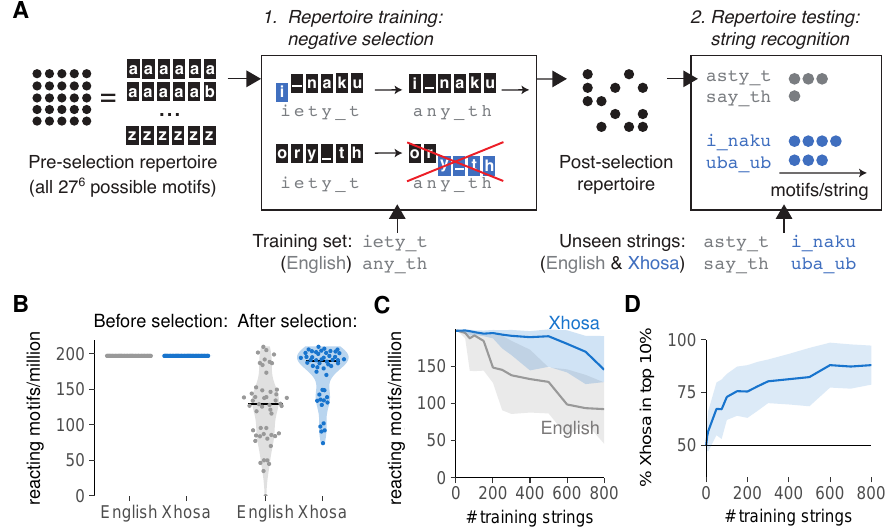
Figure 3. An artificial immune system tasked with language recognition discriminates self and foreign after negative selection on a subset of self. ( A ) Simulating negative selection in silico: (1) Motifs in the unbiased pre-selection repertoire (with all possible 27 6 ≈ 400 million motifs of six characters (a–z and _)) are deleted if their affinity for any of the training strings exceeds the functional response threshold t . (2) Unseen English and Xhosa strings are exposed to the post-selection repertoire to find the number of remaining motifs reacting to them with affinity ≥ t ; ( B ) reacting motifs per million for unseen English and Xhosa strings, before and after negative selection on 500 English strings ( ∼ 1 page of text). Horizontal lines indicate medians. Each dot represents a test string, all from a single simulation; ( C ) median and interquartile range of English- and Xhosa-reactivity after negative selection on English strings, obtained from one simulation per training set size; ( D ) percentage of Xhosa strings among the 10% of strings with the most reacting motifs after negative selection on English strings (mean ± standard deviation, SD, of 30 simulations). No discrimination should result in equal amounts (50%) of English and Xhosa strings in this top 10%. Throughout this figure, we tested 50 English and 50 Xhosa strings using an affinity threshold t = 3 for negative